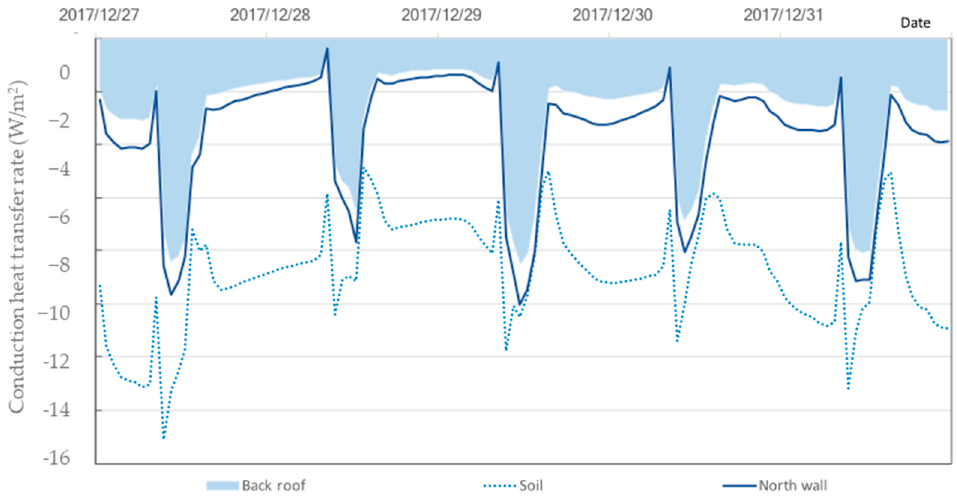
Figure 23. Convection heat transfer on the inside surfaces of the CSG on cloudy days.